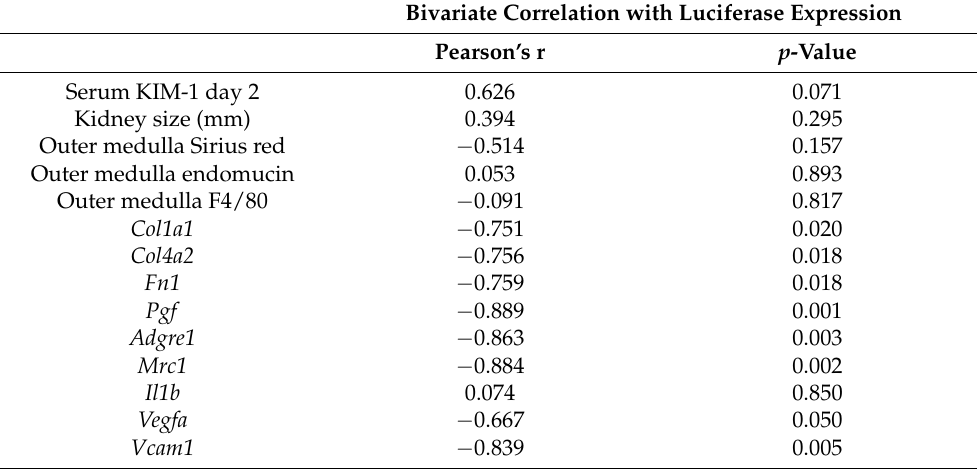
Table 1. Bivariate correlations between transfection efficiency and parameters in sFLT1-treated mice.